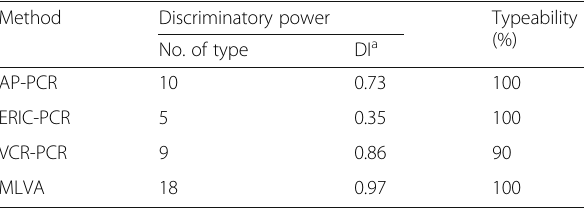
Table 4 Discriminatory power and typeability of fingerprinting methods used in this study for typing of V. cholerae isolates